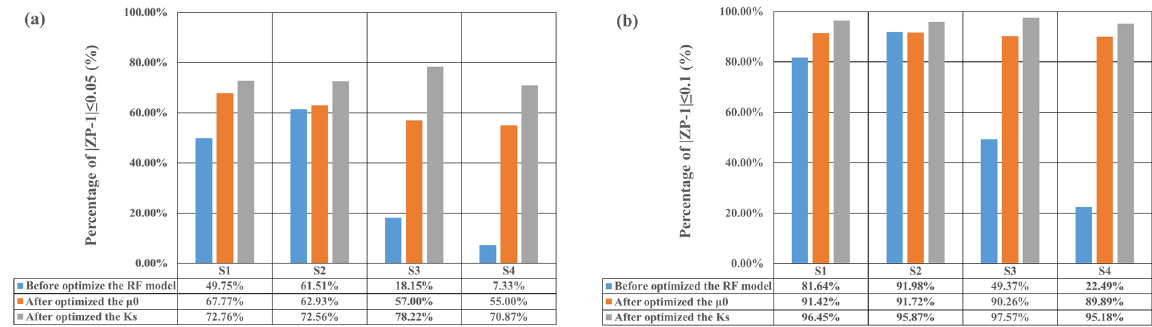
Figure 9. Comparison of rolling force qualification rates: ( a ) δ ZP ≤ 0.05, and ( b ) δ ZP ≤ 0.1.